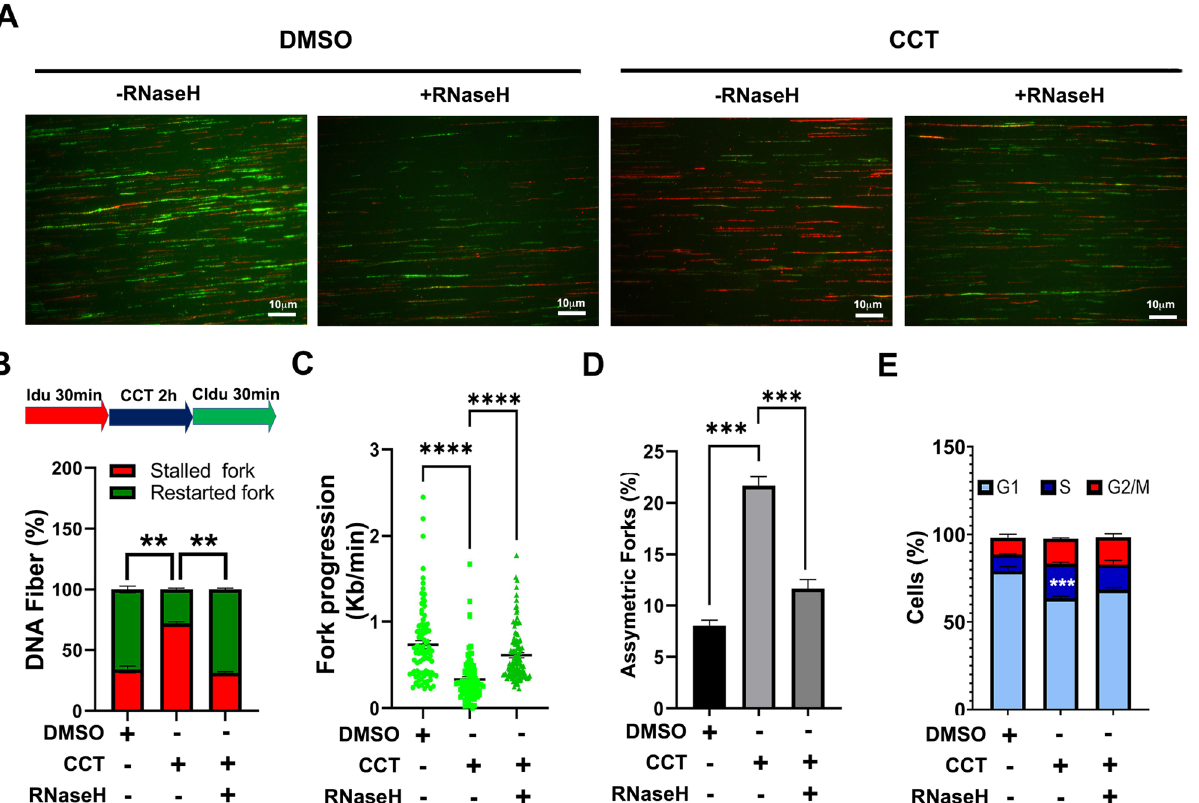
Figure 4. Mediator kinase inhibition alters replication fork dynamics and triggers S-phase delay in UtSM cells. ( A ) Representative images of combed DNA fibers from IdU/CldU pulse-labeled parental or RNAaseH overexpressing (−/ + RNaseH) UtSMCs cells treated with DMSO or CCT251545 (CCT; 100 nM). ( B ) Top, pulse labeling scheme. CCT251545 was added for 2 h between 30 min Idu (red) and CldU (green) pulses. Bottom, percentage of singly labeled fibers retaining only first (Idu) or second (CldU) label indicative of stalled or re-started forks, respectively. ( C ) Velocity of fork progression as determined from CldU tract lengths (kb/min). ( D ) Percentage of bidirectional asymmetric forks, represented as percentage of forks relative to total number of forks in the field. ( E ) Unsynchronized parental or RNaseH overexpressing (−/ + RNaseH) UtSMCs treated with DMSO or CCT251545 (CCT; 100 nM) for 3 days were stained with propidium iodide and analyzed by flow cytometry. Percentage of cells in each cell cycle phase is plotted. Statistical significance was calculated using One-Way ANOVA followed Tukey’s Post hoc test, **** p ≤ 0.0001, *** p < 0.001; ** p <